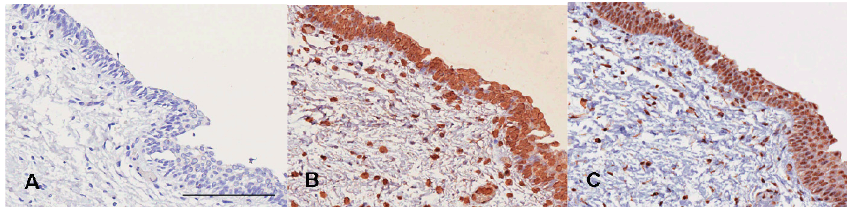
Figure 1. Normal urotheliun. ( A ) Mouse IgG control; ( B ) 5-Methylocytosine (5-MeC) immunohistochemistry; ( C ) DNA (cytosine-5)-methyltransferase 1 (DNMT1) immunohistochemistry. High levels of both 5-MeC and DNMT1 present in the normal urothelium. Bar = 200 µm.